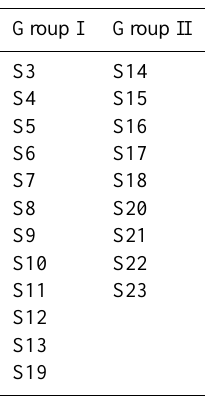
Fig. 7. Predicted flows for April in Group I